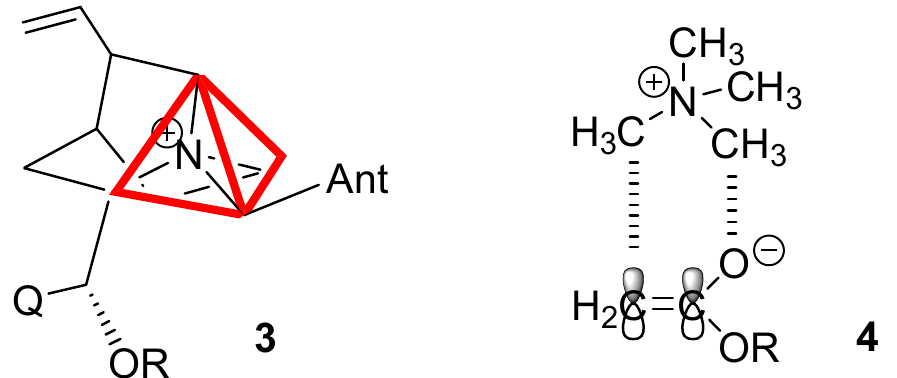
Figure 3. Tetrahedron model ( 3 ) and π -facial model ( 4 ) proposed for the explanation of the enantioselectivity of the alkylation of glycine enolates.